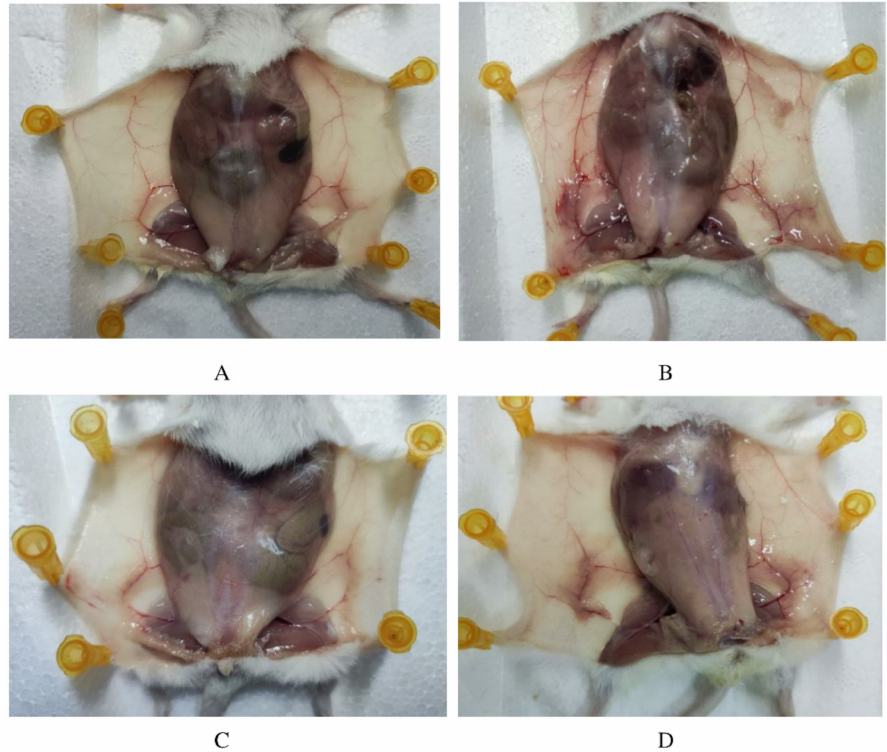
Figure 1. ALE alleviated LPS-induced mammary inflammation in mice. Note: ( A ): Control group, ( B ): LPS group, ( C ): ALE group, ( D ): LPS + ALE